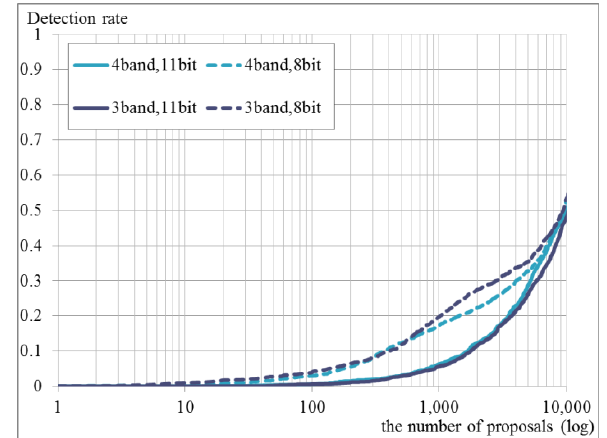
Figure 5. Comparison of detection rate between satellite and aerial images